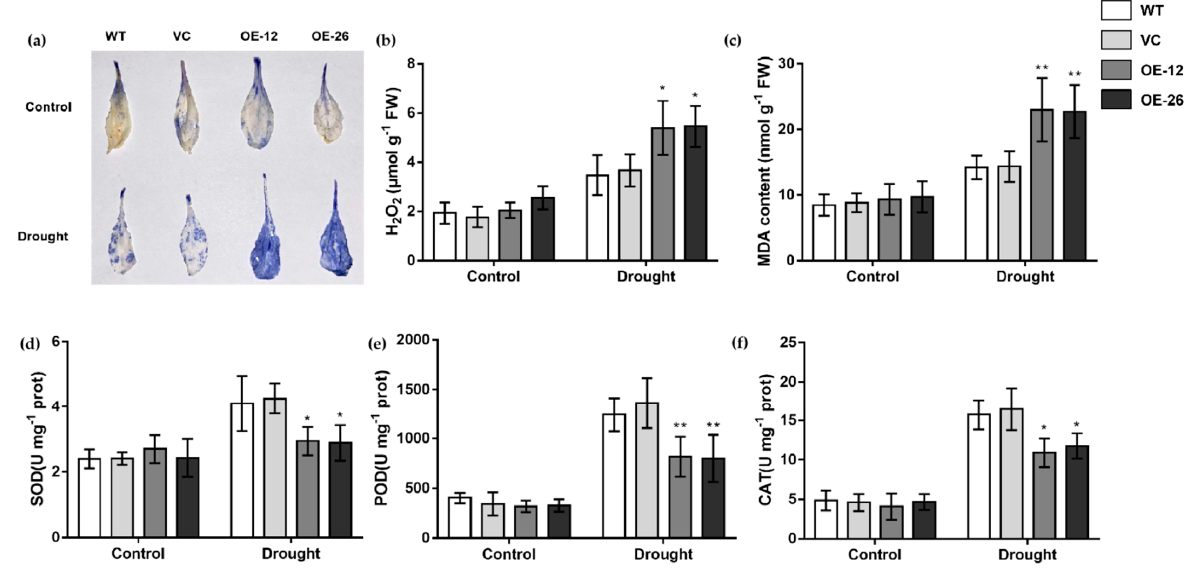
Figure 6. NBT staining, H 2 O 2 accumulation, MDA content and antioxidant enzyme activities of TaWRKY133 transgenic Arabidopsis under 10 d of drought treatment. ( a ) NBT staining. ( b ) H 2 O 2 accumulation. ( c ) MDA content. ( d ) SOD activity. ( e ) POD activity. ( f ) CAT activity (* p < 0.05 and ** p < 0.01). No asterisk means non-significant difference.